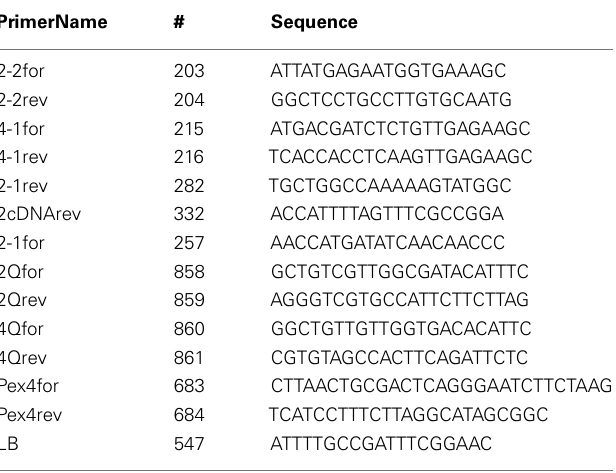
TableA1 | Sequences and names of primers used in this work as